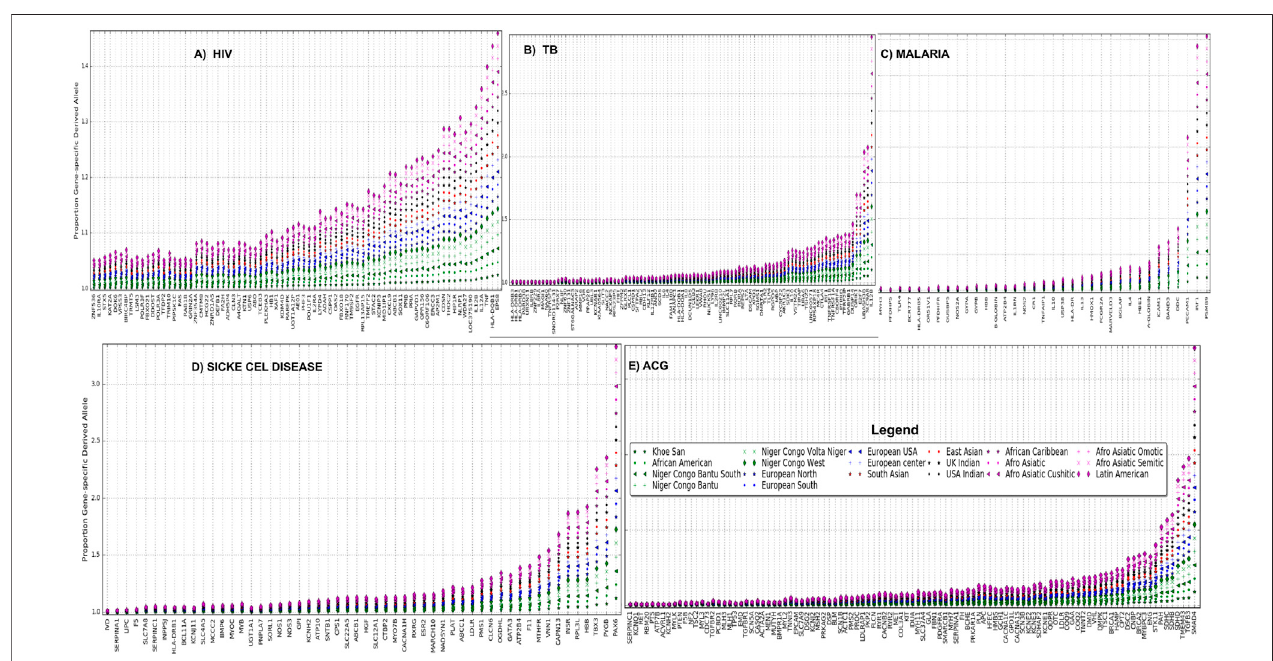
FIGURE4|(A) HIV, (B) TB, (C) malaria, (D) sicklecelldisease,and (E) ACGgene-speci fi cproportionofderivedallelesacross20worldwideethnolinguisticcultural